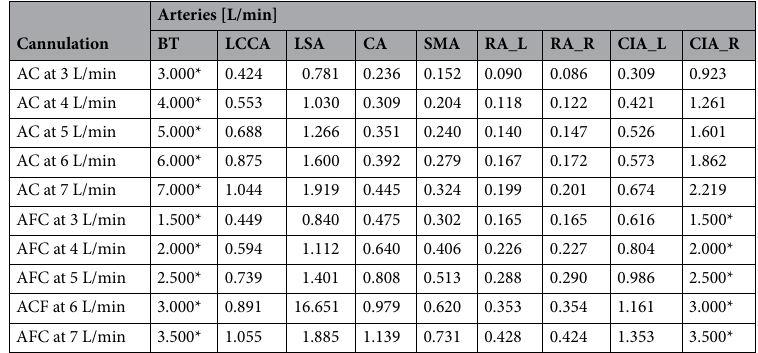
Table 1. Flow data of entire arteries in AC and AFC for the FSI simulation. AC axillary cannulation, AFC axillary and femoral cannulation, BT brachiocephalic trunk, CA celiac artery, CIA_L left common iliac artery, CIA_R right common iliac artery, FSI fluid–structure interaction, LCCA left common carotid artery, LSA left subclavian artery, RA, L left renal artery, RA right renal artery, SMA superior mesenteric artery. *Indicates the inflow.